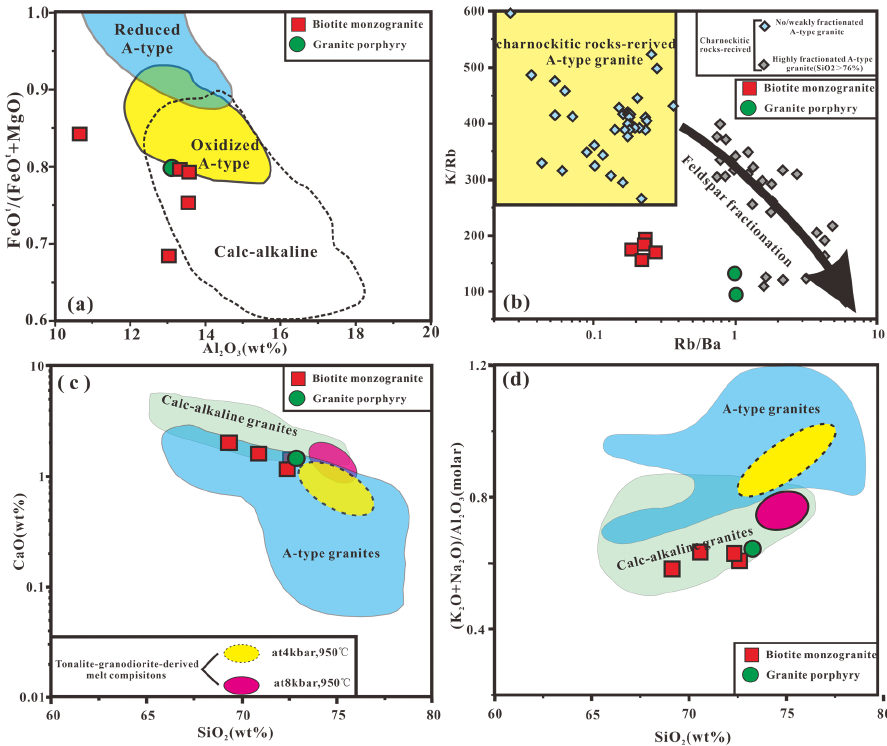
Figure 10. ( a ) Plots of Al 2 O 3 vs. FeO t /(FeO t + MgO) (after Dall’Agnol and de Oliveira, 2007 [53]). ( b ) Rb/Ba vs. K/Rb. ( c ) SiO 2 vs. CaO. Data sources for charnoclitic rocks derived from A-type granite were after Landenberger and Collins, 1996; Zhao et al., 2008; Ji et al., 2019b [47,48,54]. ( d ) SiO 2 vs. molar (Na 2 O + K 2 O)/Al 2 O 3 (tonalite–granodiorite-derived melt compositions and dates of A-type granites and calc-alkaline granitoids were after Patiño Douce